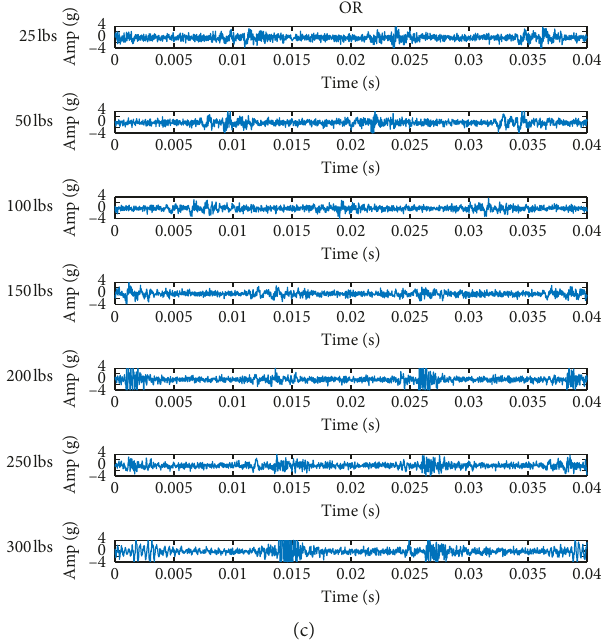
Figure 12: Vibration signals acquired from three states of rolling bearing in MFPT: (a) N, (b) IR, and (c) OR.